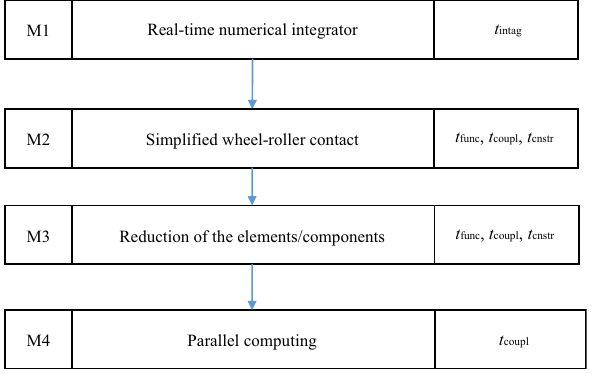
Fig. 10 Stages to model RT-SBTR. In each stage, the columns from first to third represent name, task, and associated time of that stage, Fig. 10 to obtain a model suitable for real-time application with reasonable trade-offs with the accuracy. The execu- tion time that is associated with tasks has been presented in the third column of Fig. 10. The significant reduction in the associated time leads to reducing the total time required (i. e., t out ) to execute in each step.